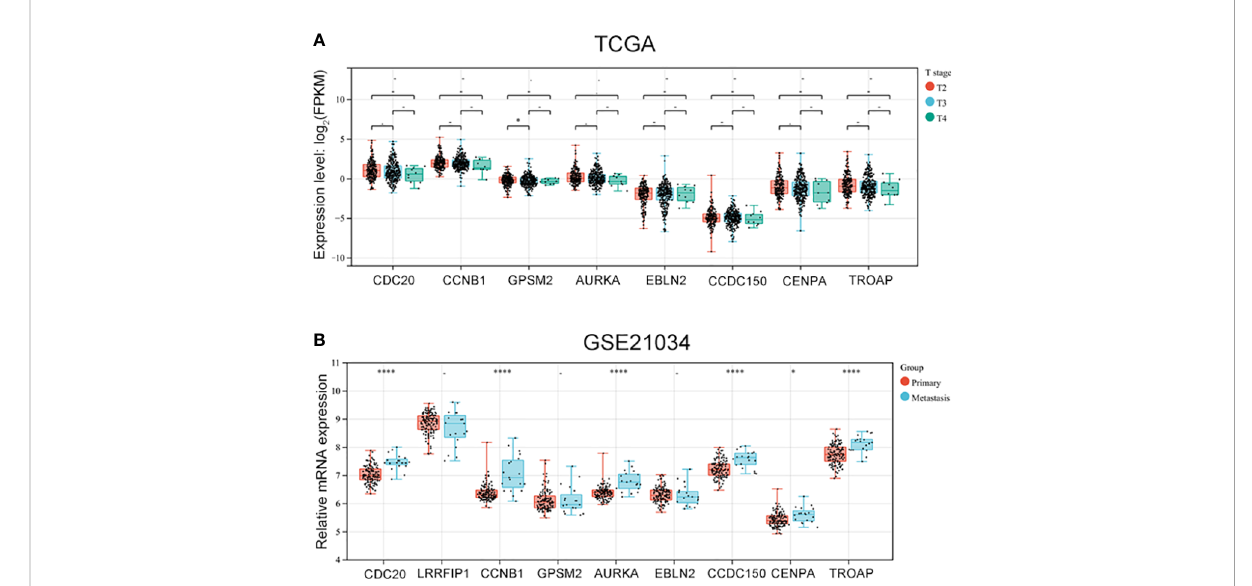
FIGURE 4 The expression of vinblastine resistance-related genes in different tumor stage from different databases. (A) The expression of eight vinblastine resistance-related genes in different T stage from TCGA database. (B) The expression of nine vinblastine resistance-related hub genes in primary and metastasis PCa patients from GSE21034 datasets. – represents no statistical differences. * represents P <0.05, **** represents P <0.0001.